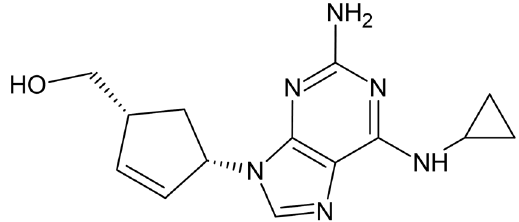
Figure 1. Chemical structure of